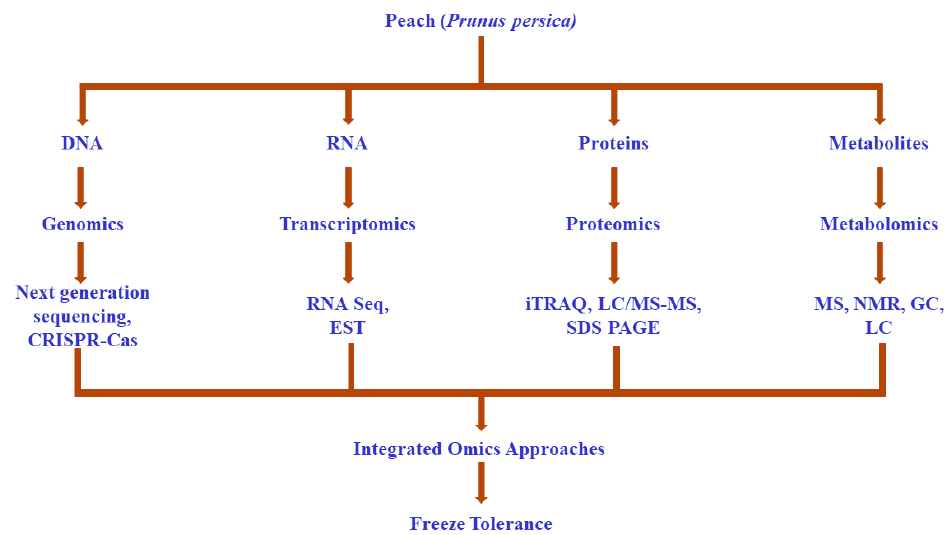
Figure 1. Understanding of freezing tolerance via omics